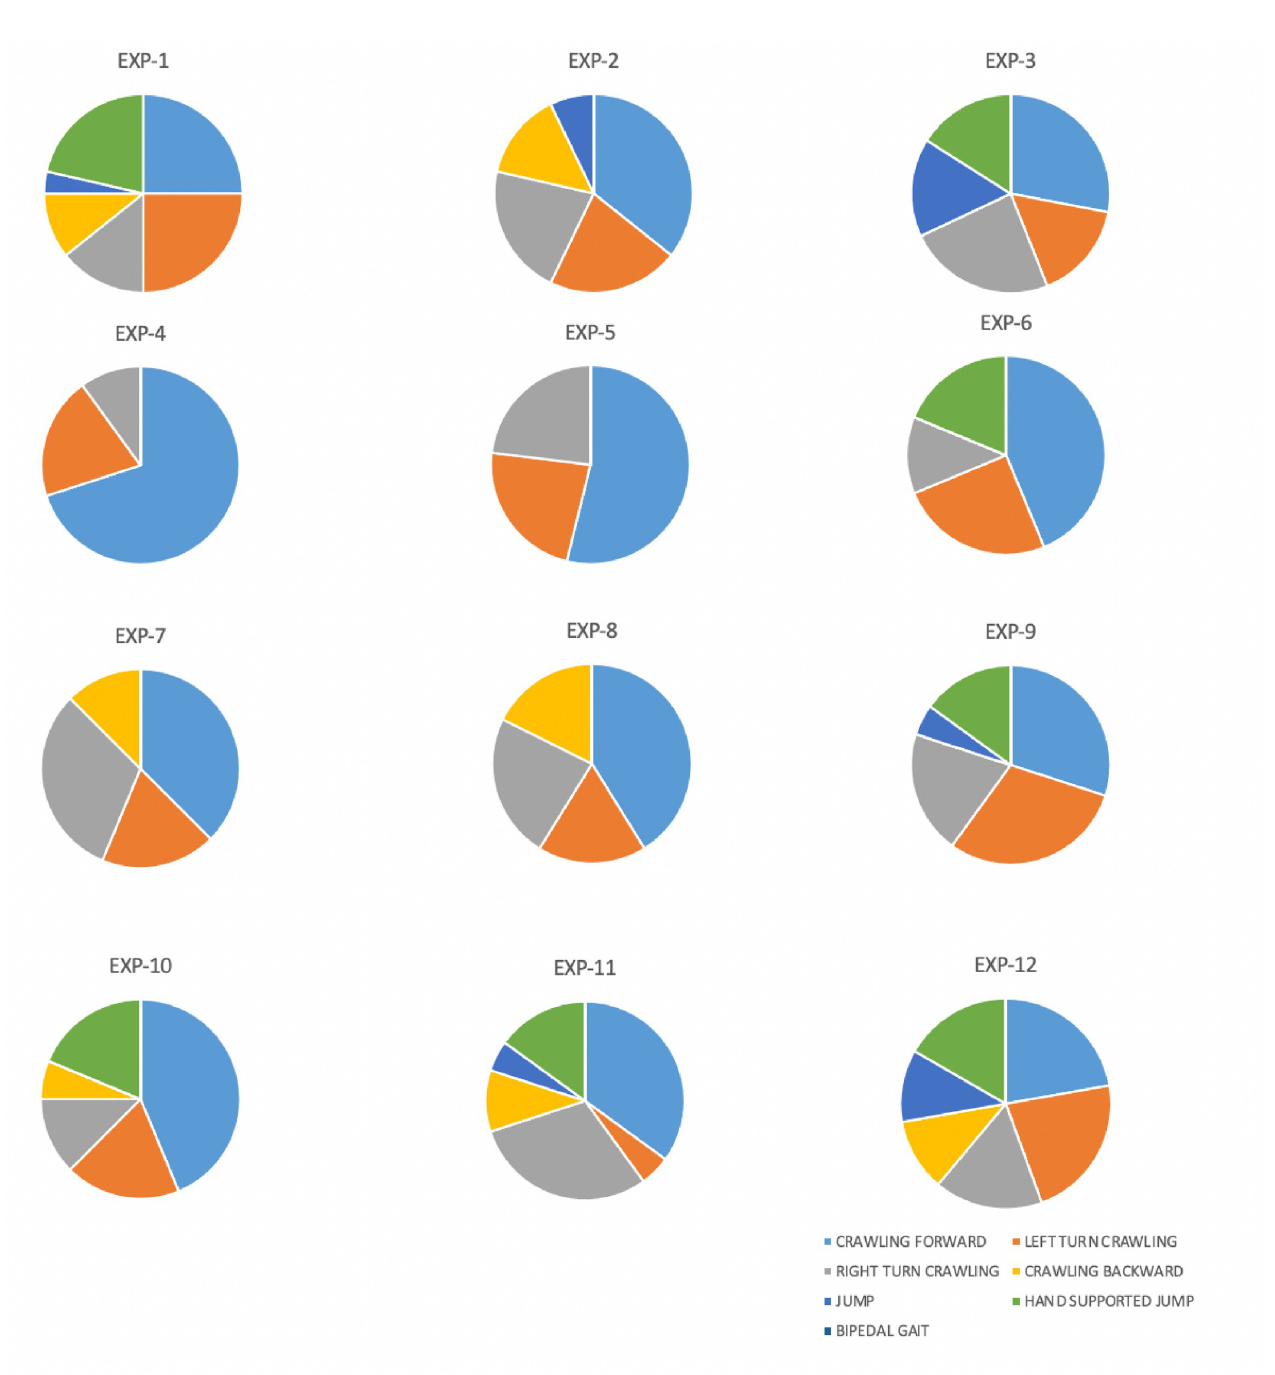
Fig 3. Pie charts for experienced performers. These pie charts show the movements chosen by the experienced performers: crawling forward, turning left, turning right, crawling backward, jumping, hand-supported jumping, and bipedal gait.